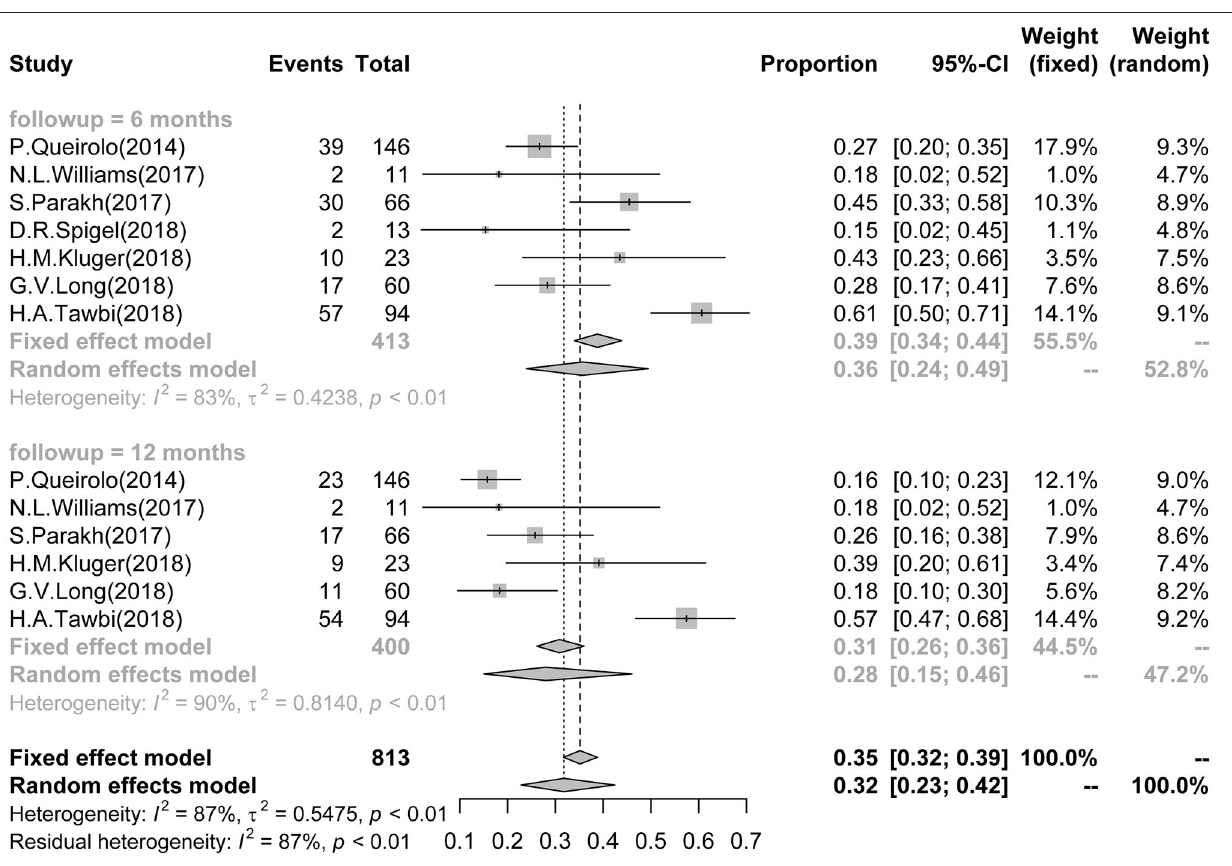
FIGURE 2 | Association between ICIs and Short-term PFS in BM patients. Forest plots showing 6- and 12-month PFS in BM patients treated with ICIs. ICI, immune checkpoint inhibitor; BM, brain metastasis; PFS, progression-free